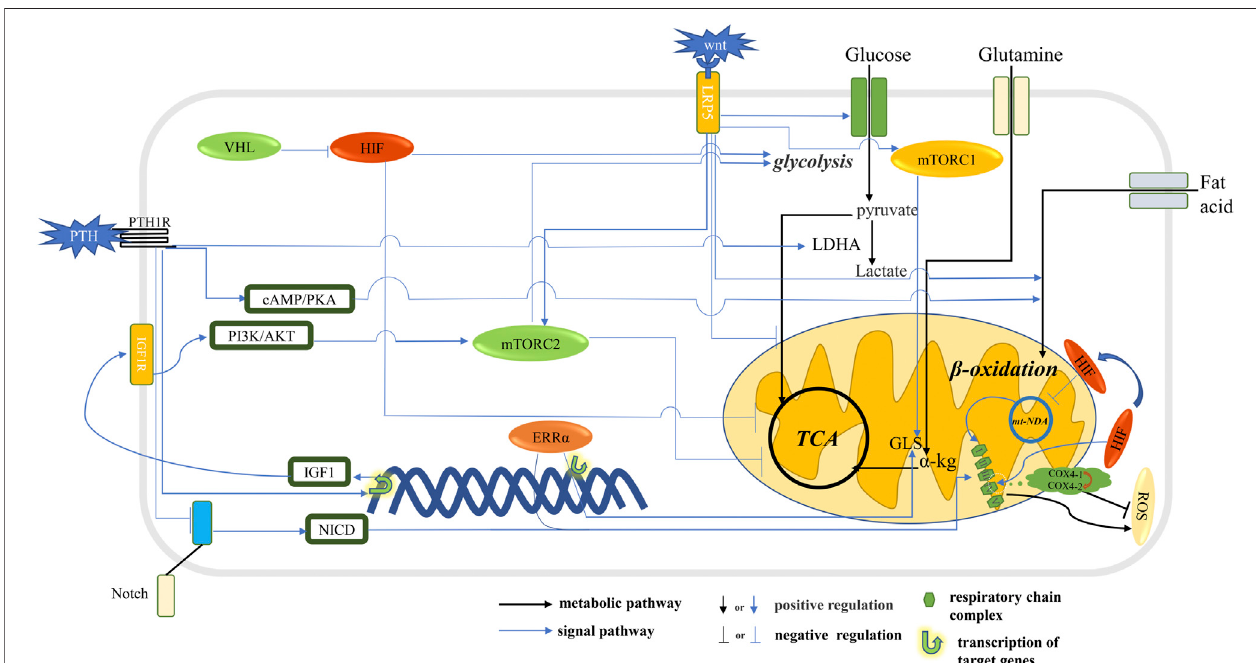
FIGURE 1 | Signal pathway that affects metabolic pathways in osteoblast. The HIF stimulates glycolysis and inhibits oxidative phosphorylation. The Wnt signaling pathway and PTH stimulate glycolysis and inhibit oxidative phosphorylation through mTORC2 and promote the ß -oxidation of fatty acids. Notch signaling pathway and ERR α stimulate the expression of respiratory chain complex and promote mitochondrial OXPHOS. The Wnt signaling pathway and ERR α stimulates GLS expression, therebypromotingtheconversionofglutamineto α -kgintotheTCAcycle.TheHIFsignalingpathwaypromotesglycolysis fl uxandinhibitsTCAcyclingandreduces ROS